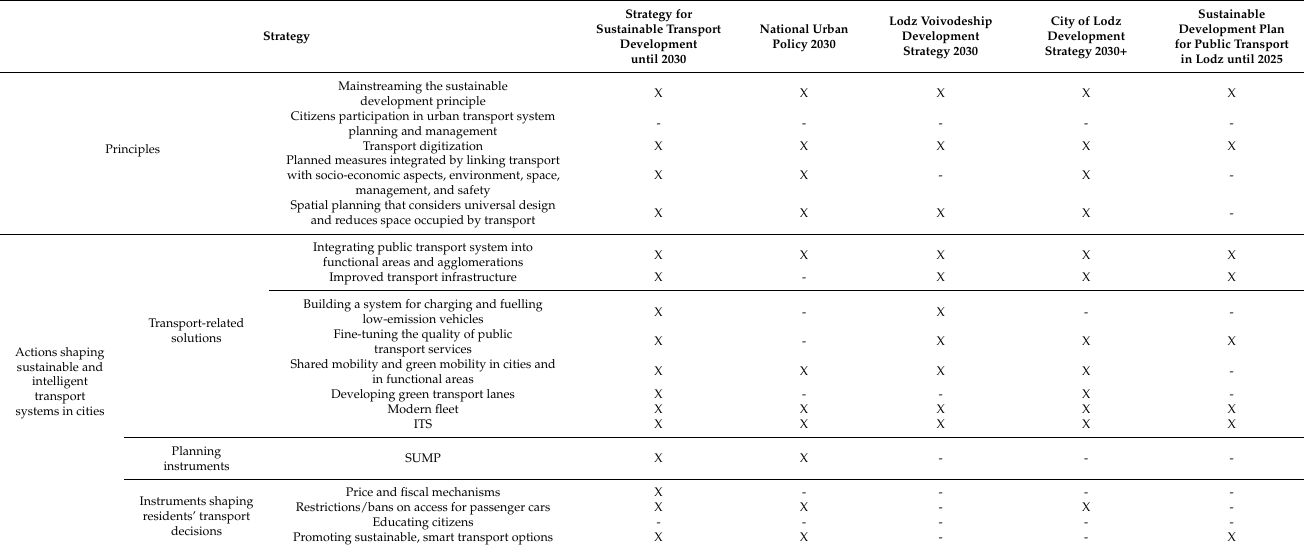
Table 5. Results of the analysis of government and local authorities’ strategies in the light of transport policy and actions aimed at developing sustainable urban